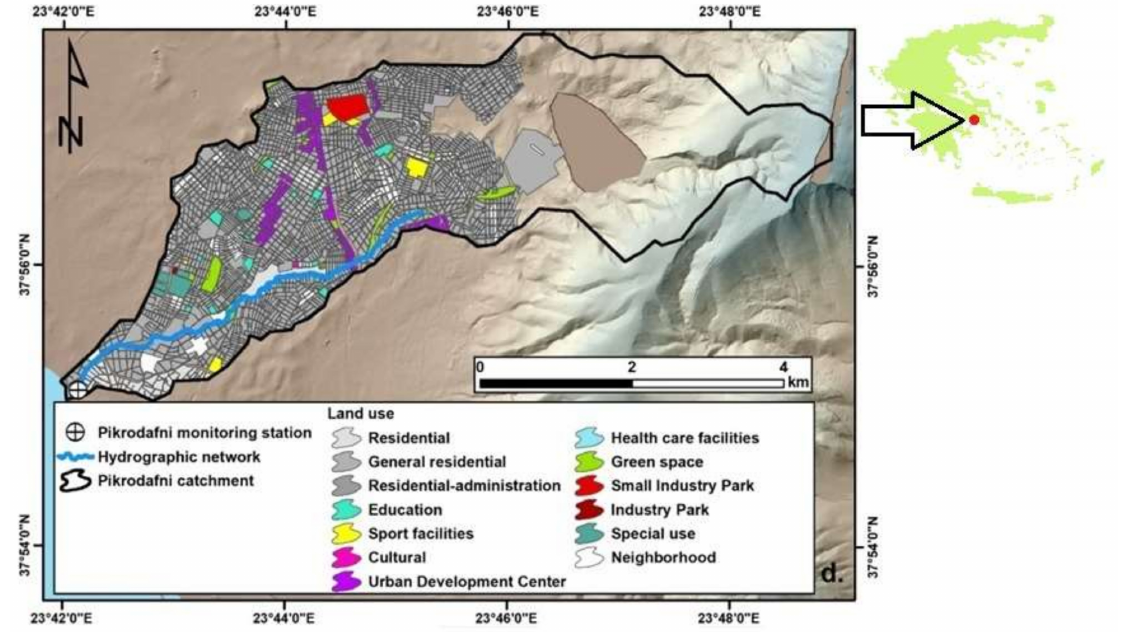
Figure 1. (From Mentzafou et al. [24].) The Pikrodafni urbanized catchment and the homonymous stream within the metropolitan area of Athens, Attica region,